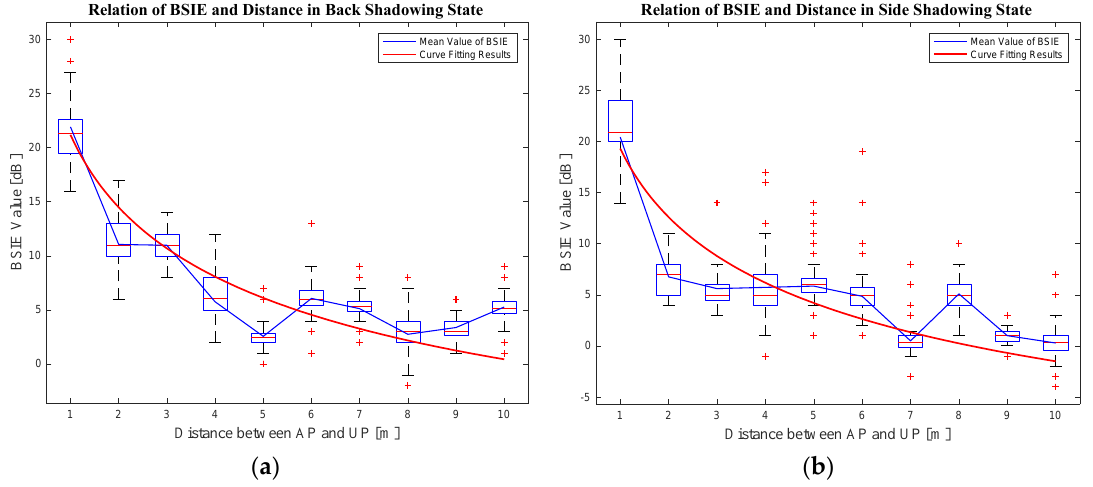
Figure 12. The relation between the BSIE and the AP–UP distance for different shadowing angles: ( a ) the relation between the BSIE and the distance in the “back” state and the curve fitting results; ( b ) the relation between the BSIE and the distance in the “side” state and the curve fitting results.